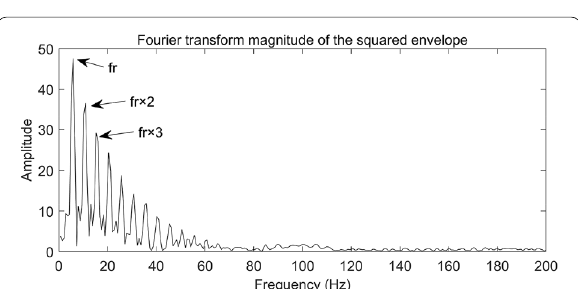
Figure 9 The squared envelope spectrum of the processed signal based on CCM